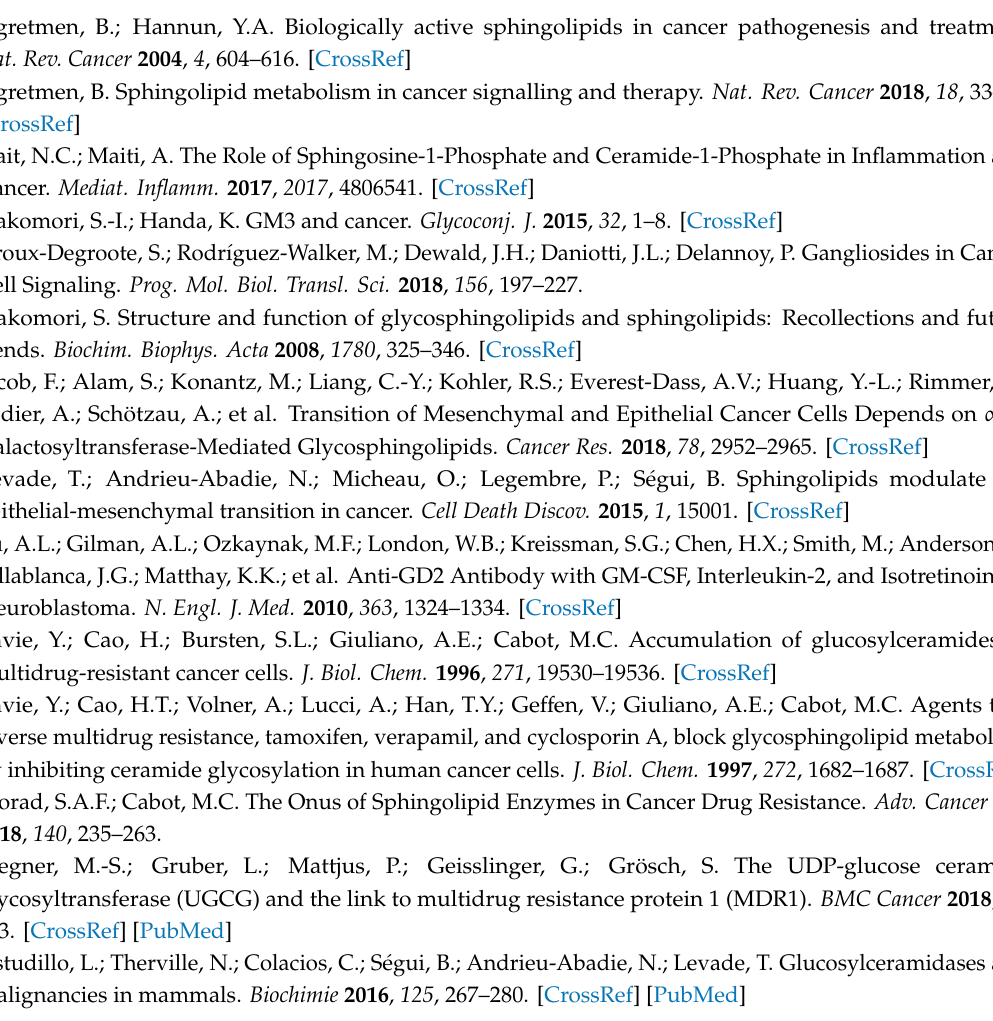
Table S1: Characteristics of cancer patients in the French Registry of Gaucher Disease (total: 658 GD patients), Table S2: Characteristics of cancers in the French Registry of Gaucher